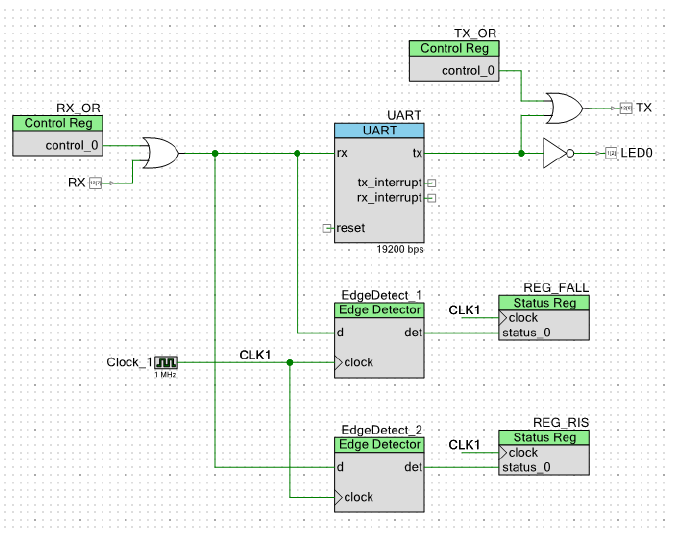
Figure 12. Modified UART block created in the slave nodes’ FPGA area.